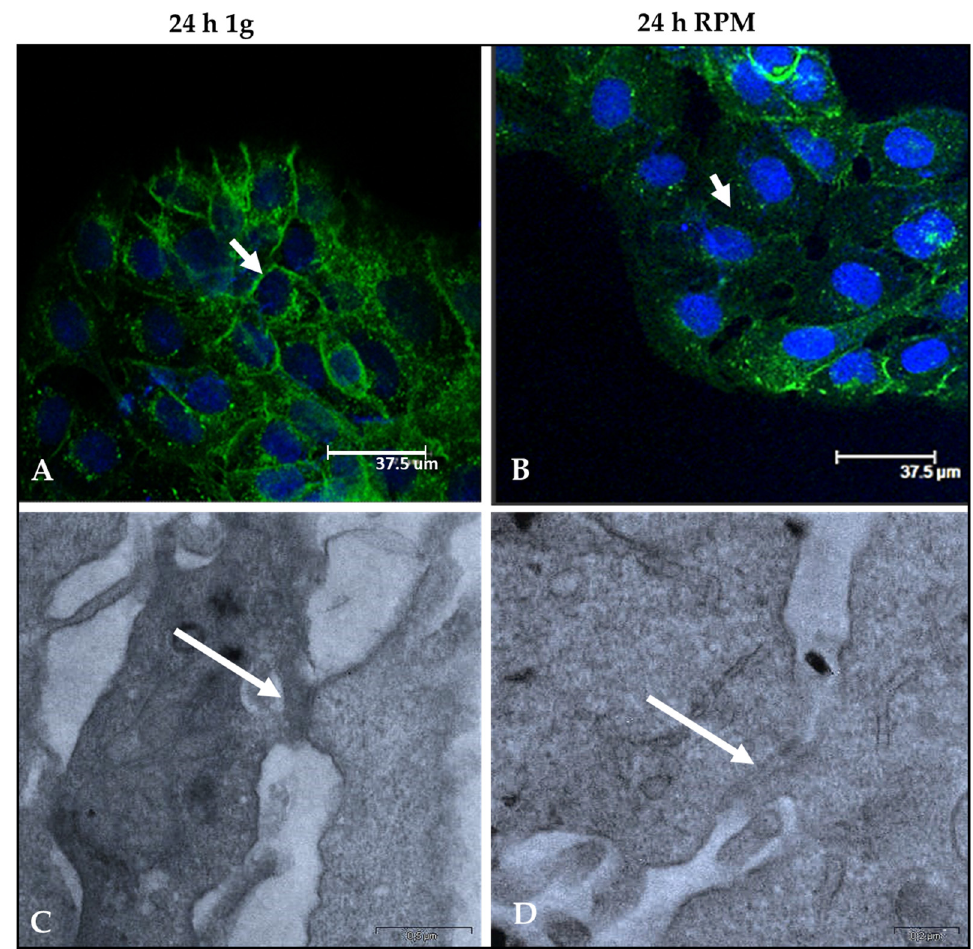
Figure 2. ( A , B ) Representative confocal images of E-cadherin distribution pattern in 1g cultured cells ( A ) and RPM cultured cells ( B ) for 24 h. There is an evident decrease of fluorescence intensity (arrows) of E-cadherin after 24 h in microgravity condition particularly at cell–cell contact with respect to the 1g condition. Scale bars 37.5 µ m. ( C , D ) representative TEM images of cells cultured in the same conditions of A and B respectively. Arrows indicate cell–cell contacts. Magnification 10,000 × Table 1. Quantitative analysis of fluorescence intensity of E-cadherin. Fluorescence intensity (SUM (I), a.u arbitrary units) was evaluated in about 500 cells. (S.E. Standard Error; 24 h 1g vs24 h RPM p < 0.01 valuated by Student’s t -test).